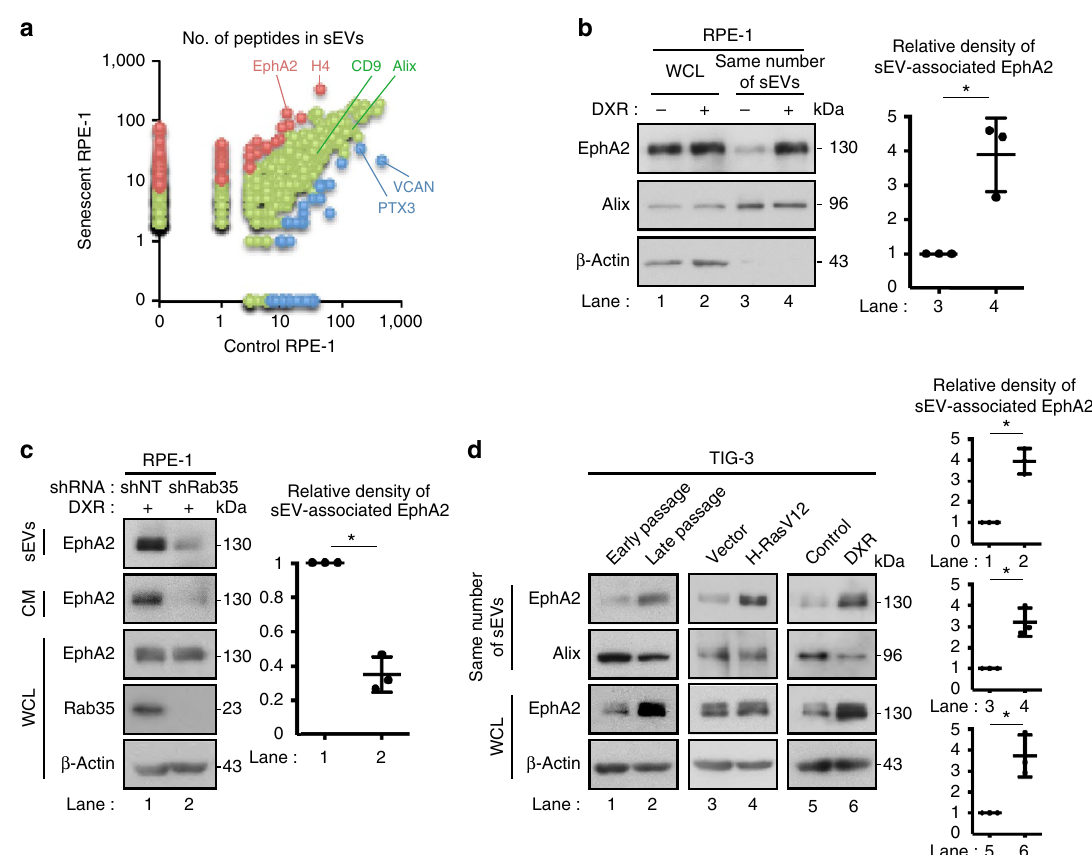
Figure 3 | Senescence induces increased secretion of sEV-associated EphA2. ( a ) Comparative proteomic analysis of sEVs secreted from control and DXR-induced senescent RPE-1 cells by using mass spectrometry. The number of peptides detected in sEVs secreted from control and DXR-induced senescent RPE-1 cells are plotted for the identified proteins. Blue and red plots represent the data for the proteins significantly enriched in sEVs secreted from control and DXR-induced senescent RPE-1 cells, respectively. Green plots represent the data for the other proteins. ( b ) Immunoblotting of EphA2, Alix and b -actin in the sEV fraction and WCL of control and DXR-induced senescent RPE-1 cells. The same number of sEVs was loaded in each lane. Dot plot represents the relative density of sEV-associated EphA2 analysed by ImageJ. ( c ) Immunoblotting of indicated proteins in the sEV fraction, CM and WCL of DXR-induced senescent RPE-1 cells expressing non-targeting shRNA (shNT) or Rab35 shRNA (shRab35). Dot plot represents the relative density of sEV-associated EphA2 analysed by ImageJ. ( d ) Immunoblotting of indicated proteins in the sEV fraction and WCL of pre-senescent control and senescent TIG-3 cells. Senescence was induced by serial passage, oncogenic Ras expression or DXR-treatment. The same number of sEVs was loaded in each lane. Dot plots represent the relative density of sEV-associated EphA2 analysed by ImageJ. Replicates are biological replicates ( n ¼ 3). Error bars indicate s.d. * P o 0.05 (two-tailed t